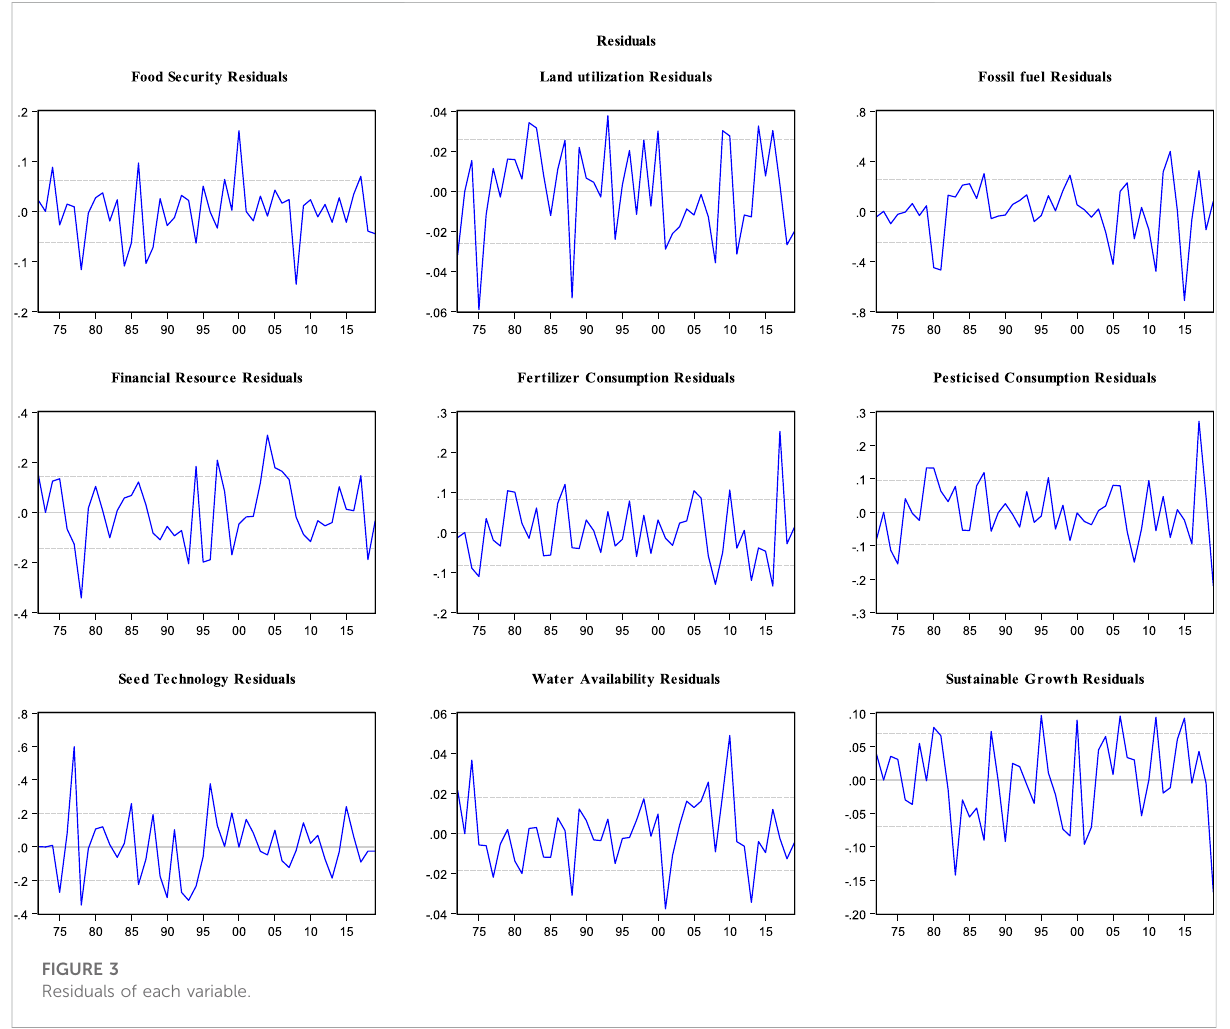
FIGURE 3 Residuals of each